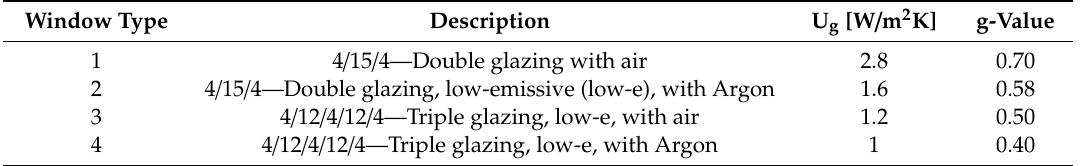
Table 2. Description of window types for parameters WT and